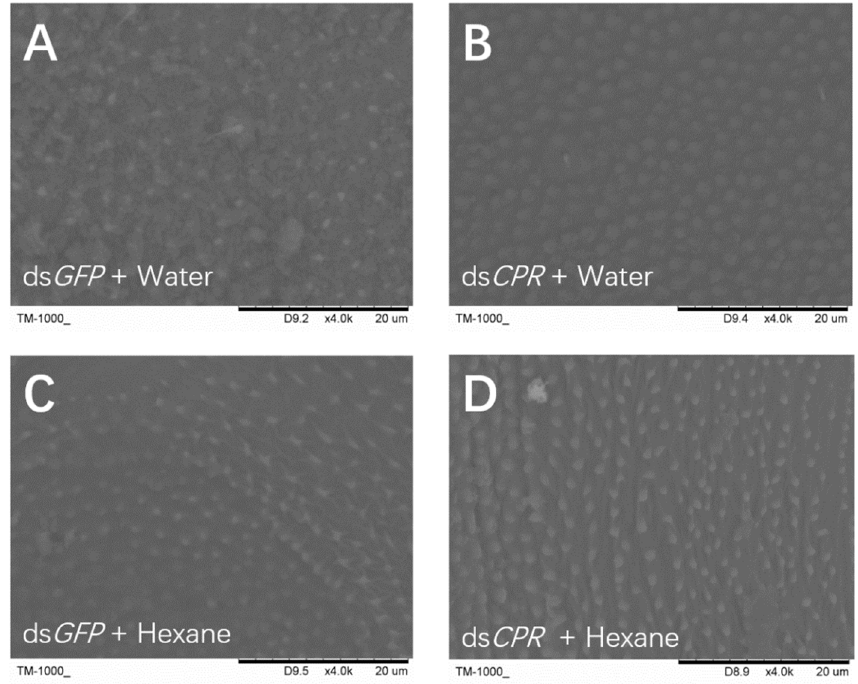
Figure 5. Scanning electron microscope analysis of the outermost layer in the abdominal surface.